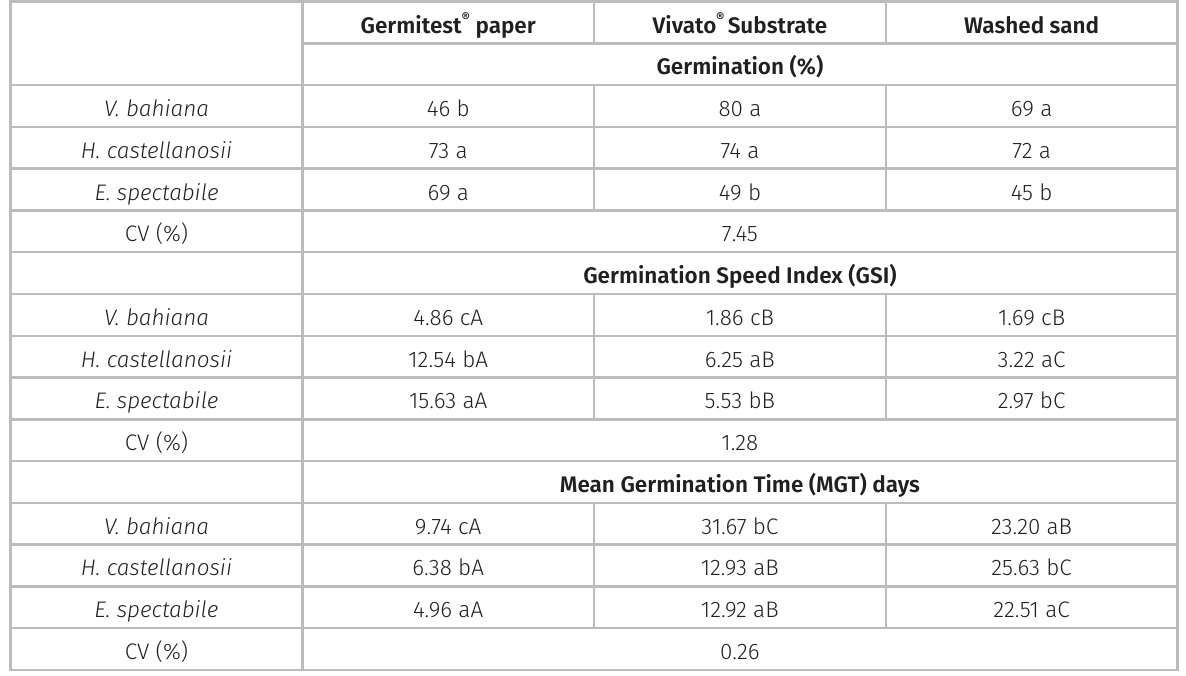
Means followed by different lowercase letters in the column and uppercase letters in the row for each variable analyzed differ from each other at 1% probability by the Tukey